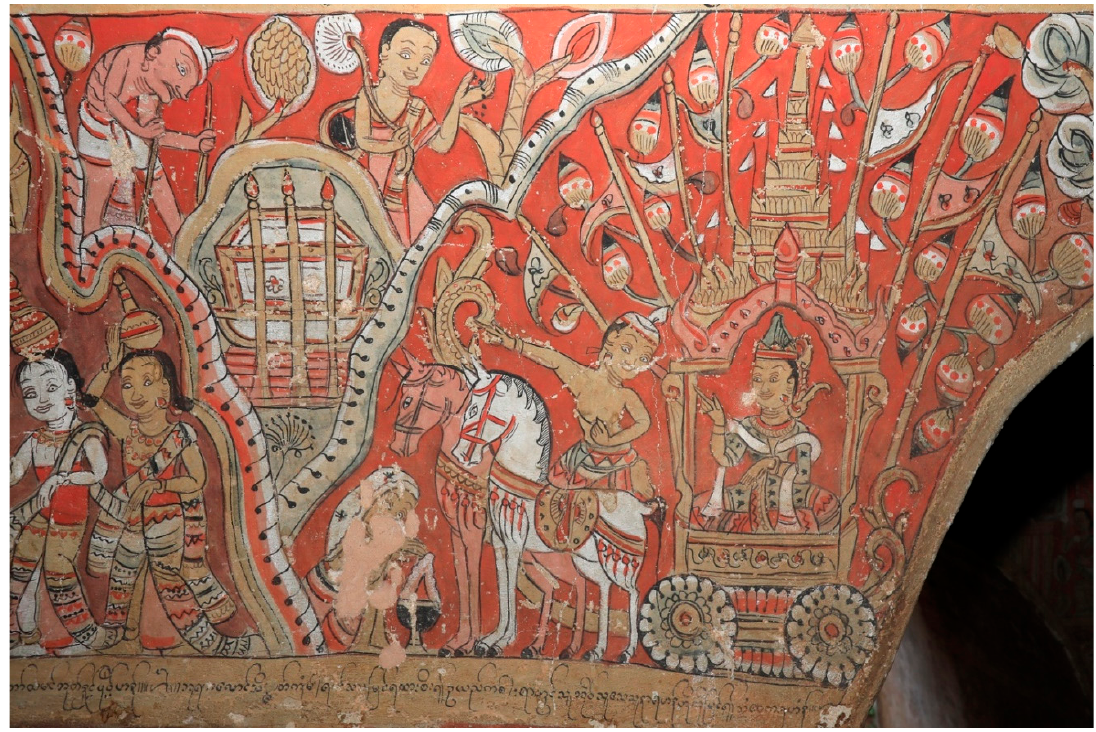
Figure 4. Anaint, Zedi Taw Taik, 18th century. Four Omens in a later interpretation. Later centuries had their own take on the terms, the story and its context. (Figures 5 and 6). The accompanying army was restored to the visual narrative, soldiers by the 18th century bearing European arms, with a foreigner positioned as Siddh¯artha’s bodyguard on the Mingala garden excursion. The appearance of foreigners in these paintings is not unique; for example, the hated Portuguese were often featured as the bad guys, the merchants about to drown, in a Mah¯ajanaka J¯ataka (539) interpretation, identifiable by their faces, head gear, as well as tunics. Elsewhere, Muslims were cast as defeated heretics, patterned after common images of what “Indians” were supposed to look like, and adding as an identifier a mosque rooftop highlighted by a crescent moon (a symbol of Islam), conveniently shown sinking into the ocean.